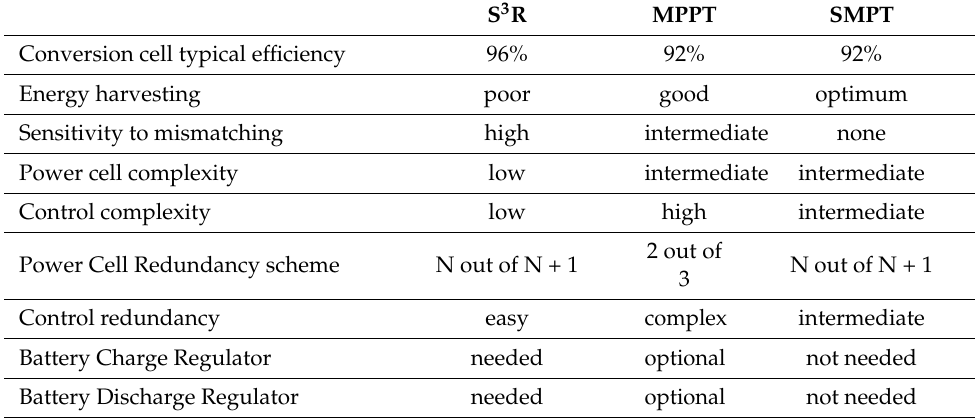
Table 1. Summary of the main features of the investigated regulation techniques.